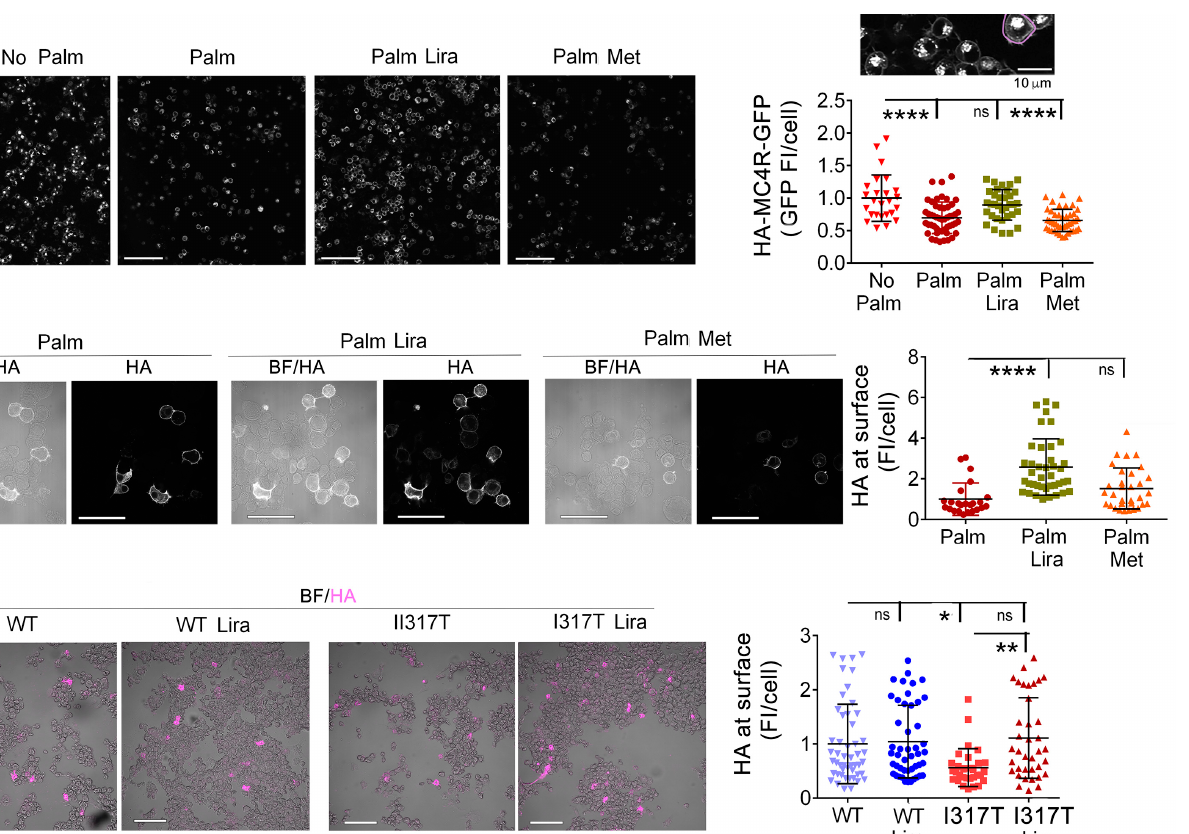
Figure 1. Liraglutide prevents changes in ER proteostasis and ER morphology caused by palmitate in Neuro2A cells. Metformin is less effective in counteracting ER stress. ( A ) Neuro2A cells incubated for 6 h with 250 µM palmitate (Palm) in the presence and absence of 100 nM liraglutide (Lira) and 2 mM metformin (Met) were fixed, immunostained with anti-ATF6 α antibody, and imaged by confocal microscopy with the 20× objective of the Olympus FluoviewFV1000 microscope. The graph shows the raw integrated fluorescence intensity (FI) of ATF6 α immunostaining within a Region of Interest (ROI) drawn to include the entire cell (magenta line of a representative cell indicated by a magenta arrowhead and shown at higher magnification above the graph, each graph symbol represents one cell, n ≥ 45 cells per condition). ( B ) Neuro2A cells treated as in panel ( A ) were fixed, immunostained with anti-ATF6 α antibody, counterstained with the nuclear stain Hoechst 33342, and imaged by confocal microscopy with the 60× objective. Graph shows FI of ATF6 α within a ROI drawn to include the nucleus (red line of a representative cell indicated by a red arrowhead and shown at higher magnification above the graph, each graph symbol represents one cell, n ≥ 45 cells per condition). ( C ) Neuro2A cells treated as in panel ( A ) were fixed and immunostained with anti- GRP78/Bip antibody and imaged by confocal microscopy with the 20× objective. Graph shows the FI of GRP78/Bip per cell (n ≥ 25 cells per condition, each graph symbol represents one cell). ( D ) Neuro2A cells treated as in panel ( A ) were imaged with the 60× objective. Yellow arrowheads indicate cells that are shown at higher magnification in the lower panel. Using ImageJ software, a segment was drawn across the cytoplasm of cells treated under the indicated conditions (a representative red segment is drawn in the “No Palm” lower panel. Graphs show the FI values along ImageJ segments drawn in the cells indicated by arrows. ** p < 0.01 **** p < 0.0001, ns, not significant).